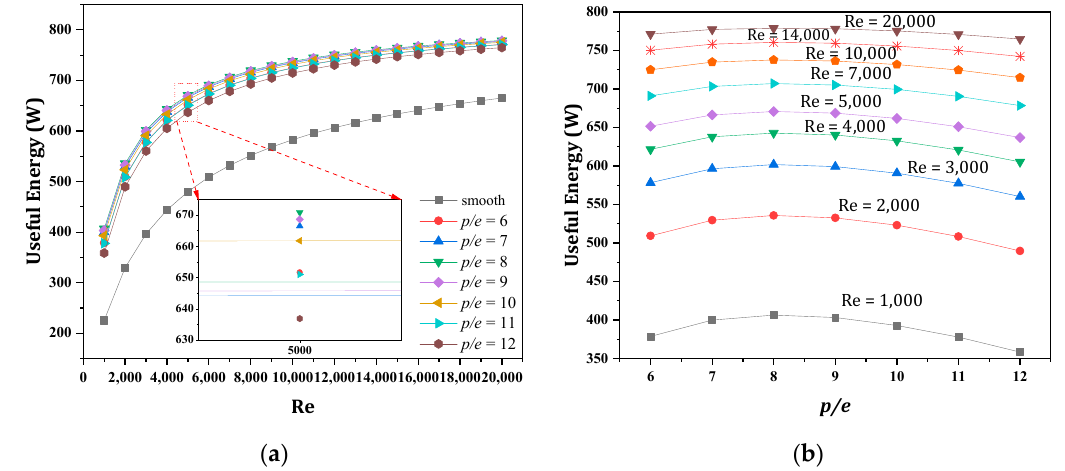
Figure 5. Useful energy versus ( a ) Re at various pitch ratios 𝑝 𝑒⁄ (in the range of 6 – 12 ) and ( b ) pitch ratios 𝑝 𝑒⁄ at various Re (1000–20,000).